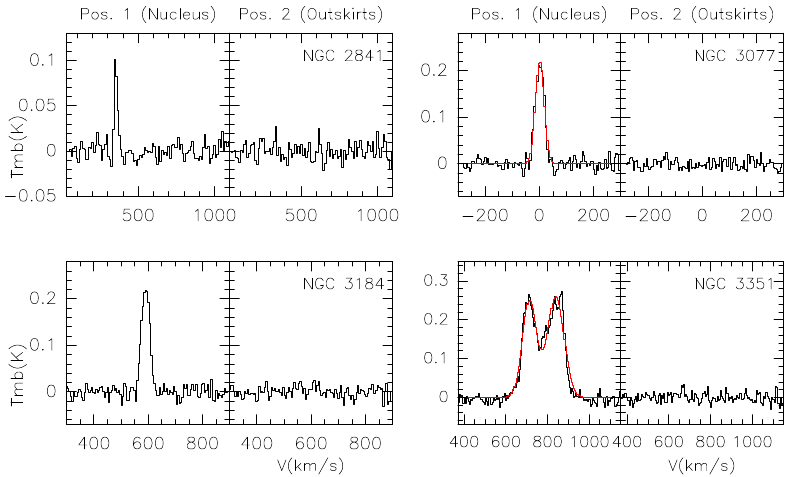
Figure 2. Spectra extracted from positions 1 and 2 indicated in Figure 1. As an example, for NGC 3077 and NGC 3351 galaxies, we show the Gaussian fits (indicated with red curves) applied to the CO(2-1)